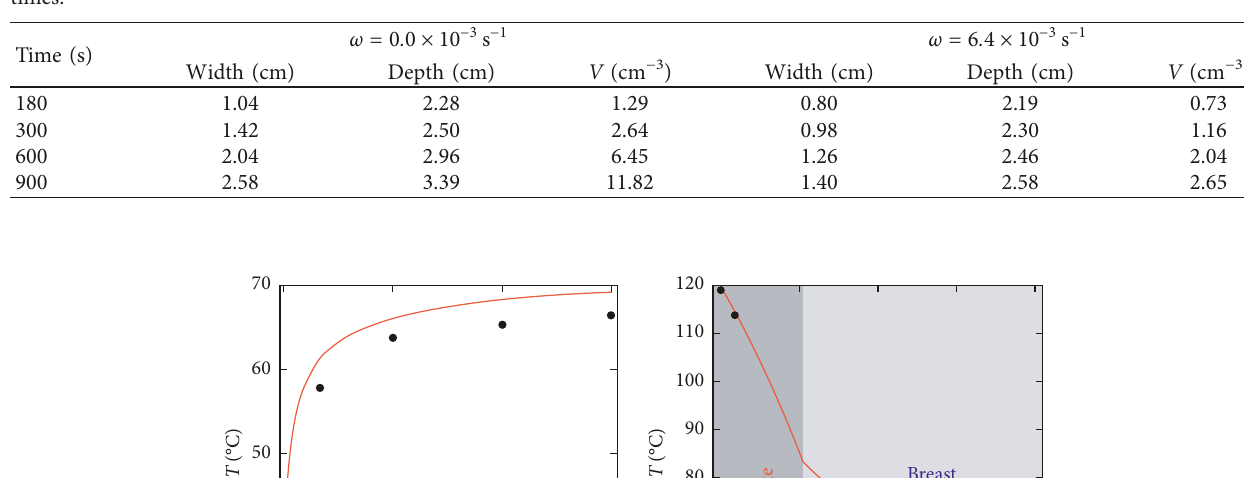
Table 4: Comparison of lesion parameters for nonperfused ( ω times.